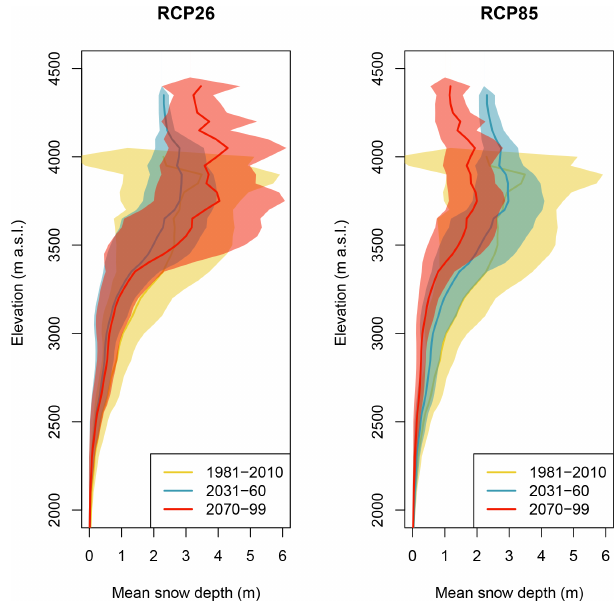
Figure 8. Hypsometry of snow depth over the Swiss Alps for RCP2.6 and RCP8.5 for the periods 1981–2010, 2031–2060, and 2070–2099. These data are derived from the ensemble mean, with shading showing ± 1 standard deviation of the values in each ele- vation band. The elevation limit in each time period corresponds to the threshold between seasonal and nonseasonal snow, or glacier accumulation zones. This demonstrates the rising equilibrium-line altitude of glaciers over the 21st century in all RCPs and the exten- sion of seasonal snow into the former glacier